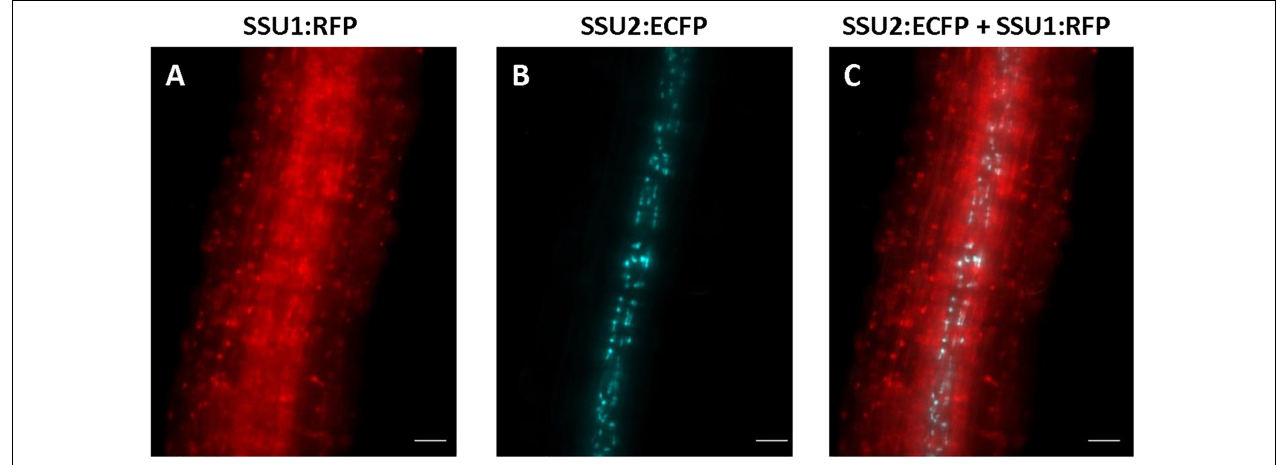
FIGURE 4 | Expression of IPMI SSU1 (A) and IPMI SSU2 (B) in roots of 6-day-old seedlings. An overlay of images is given in (C) . Scale bar is 20 µ m (A–C) .